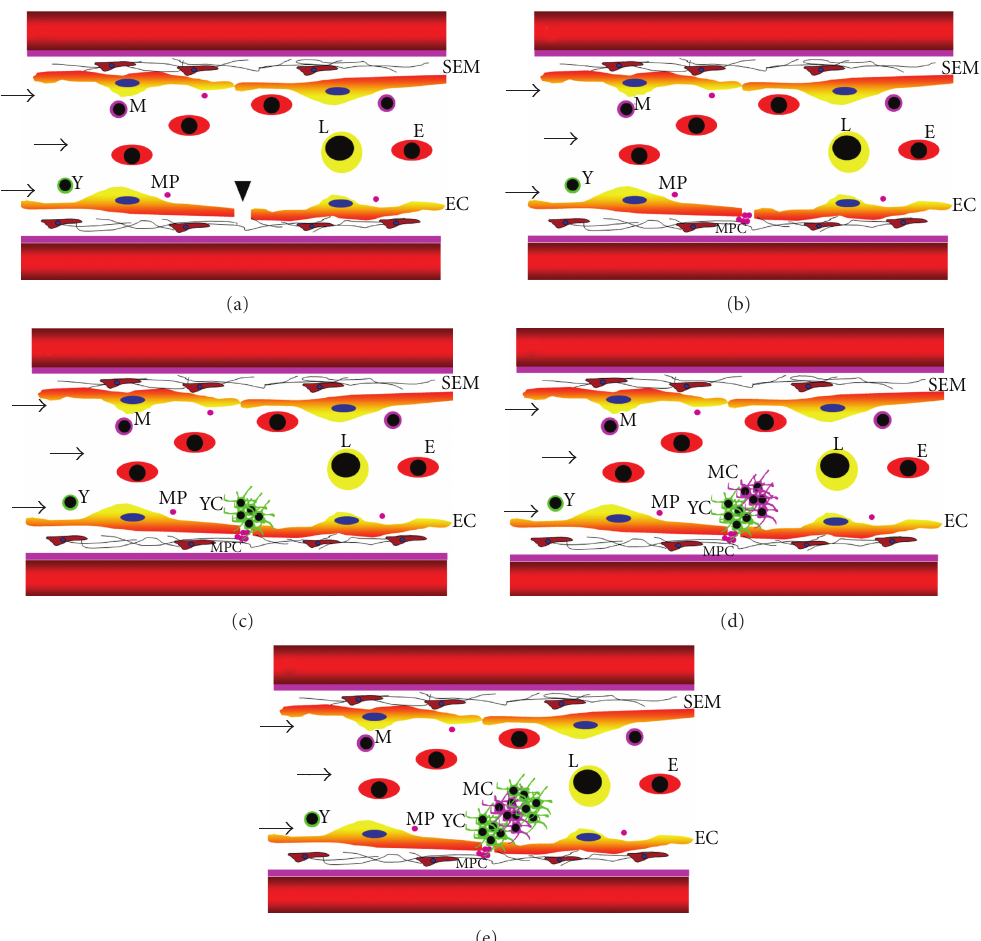
Figure 3: Schematic representation of sequential steps in growing arterial thrombus. Panels (a) through (e) show the sequence of events in thrombus growth. Arrowhead shows the site of laser injury in (a), (b) shows initiation of thrombus with the formation of microparticle (MP) clusters (MPC) followed by young thrombocyte (Y) clusters (YC) shown in (c) and then followed by a mixture of mature thrombocyte (M) clusters (MC) and YC as shown in (d) and (e) EC indicates endothelial cell; SE, subendothelial matrix; (e) erythrocytes; L, leukocytes. Arrows show the direction of blood